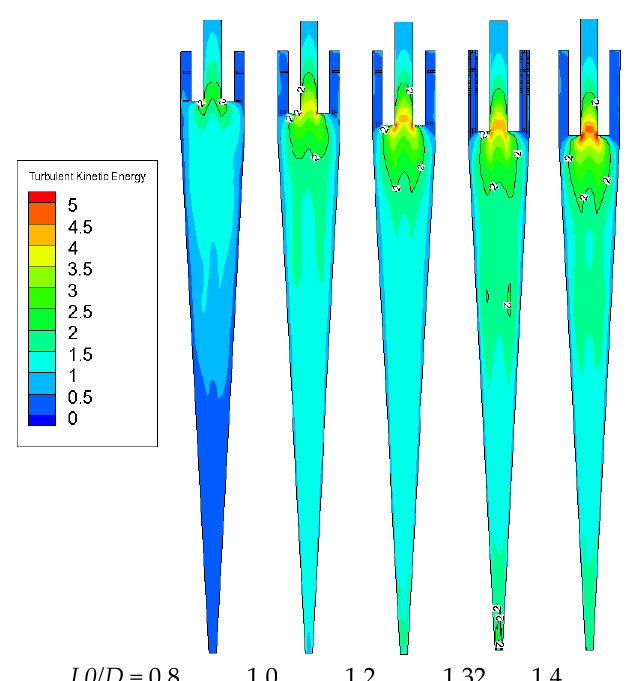
Figure 11. The turbulent kinetic energy of mini-hydrocycloness with different vortex finder depth.